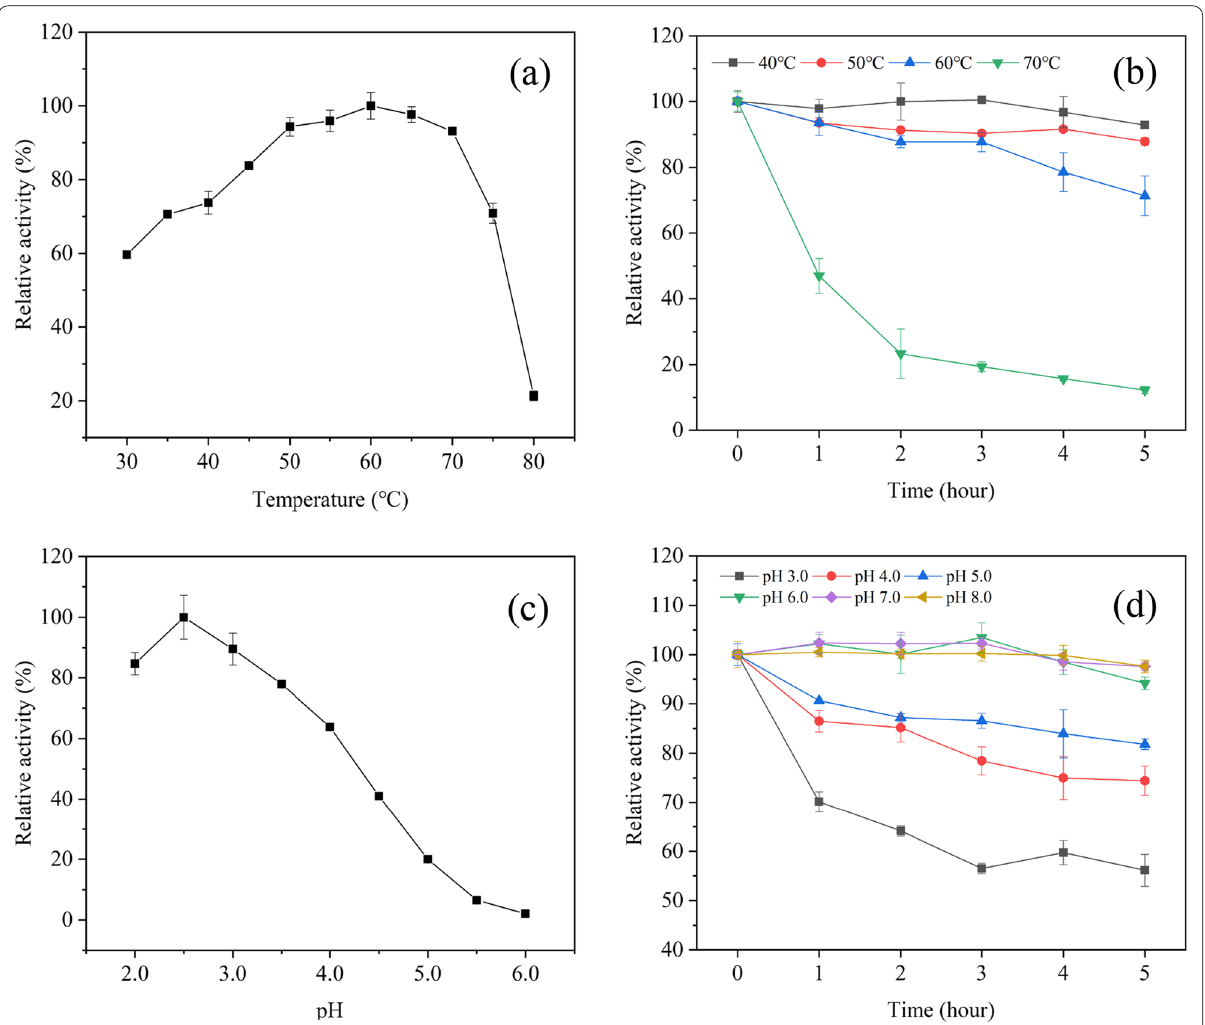
Fig. 4 Effect of temperature andpH on the activity and stability of CGLacby using 1.0 mM ABTS as a substrate. a The optimaltemperature of CGLac. b Thermostability of CGLac at40–70 °C. c The optimal pH of CGLac. d The pH stability of CGLacat pH